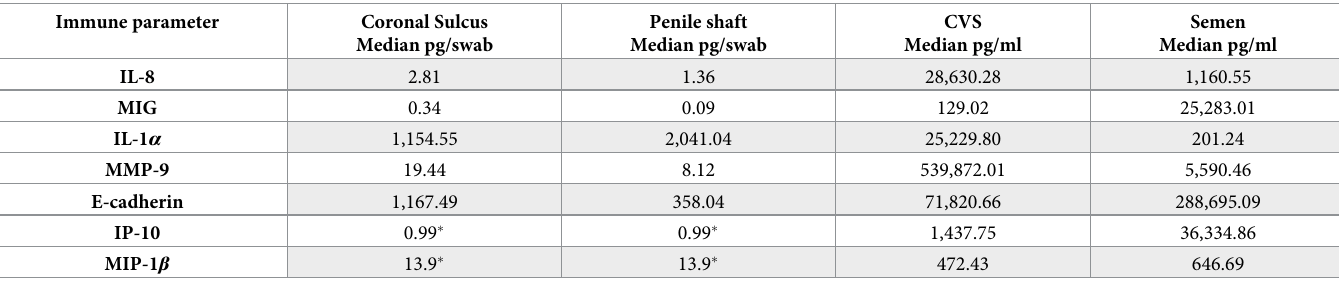
Table 2. Baseline immune parameters at different genital